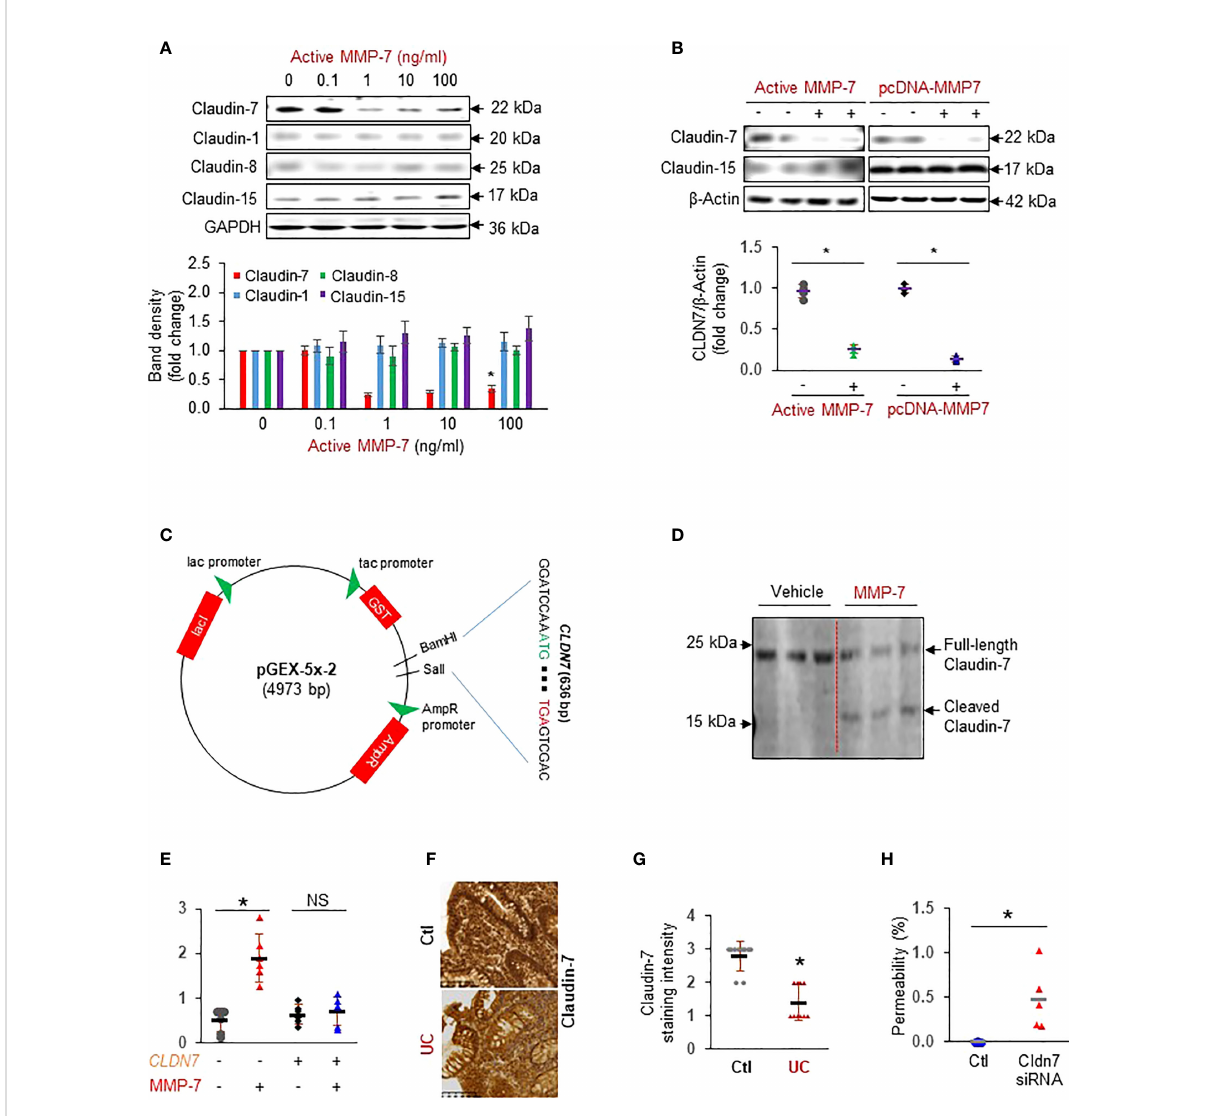
FIGURE 3 MMP-7 increases colonic epithelial permeability by degrading Claudin-7. (A) Representative Western blots showing that active MMP-7 dose- dependently decreased Claudin-7 in FHC cells. (B) Active MMP-7 and forced expression of MMP-7 suppressed Claudin-7 in CCD841 CoN cells. (C) Schematic presentation of pGEX-5x-2-CLDN7 construct used for puri fi cation of full-length human Claudin-7 protein. (D) Active MMP-7 cleaved recombinant Claudin-7 protein in enzyme assay followed by WB. (E) Increased Caco-2 monolayer permeability by active MMP-7